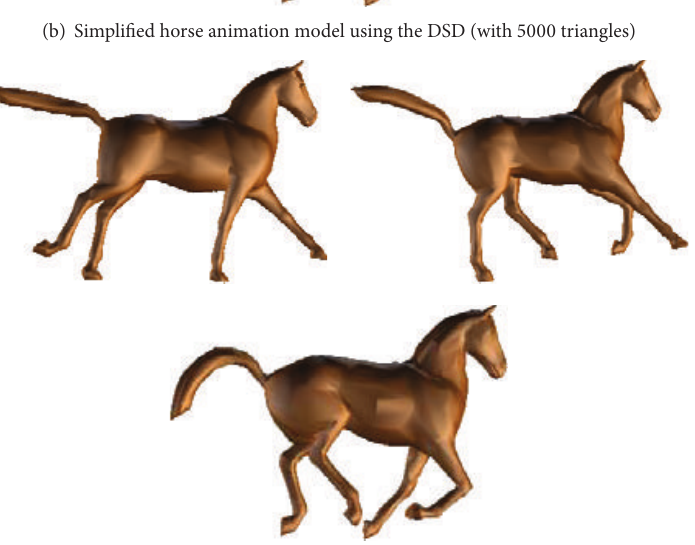
Figure 6: Simplification results of the horse animation model (frame examples 1, 21, and